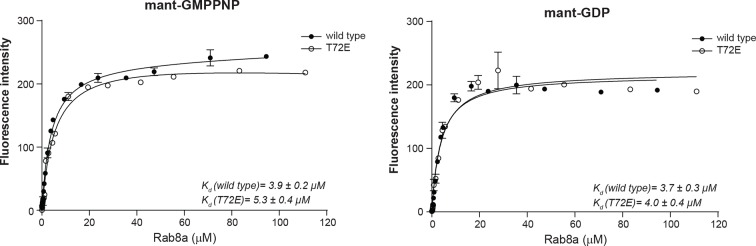
Rab8a nucleotide binding experiments.Titration experiment using Rab8a (wt and T72E) and fluorescently labeled non-hydrolysable GTP analog (mant-GMPPNP) or GDP (mant-GDP). The fluorescence signal is plotted as a function of Rab8a concentration. The dissociation constants (Kd) ± SD are indicated. Error bars are mean ± SD (n=3). SD, standard deviation; wt, wild type.